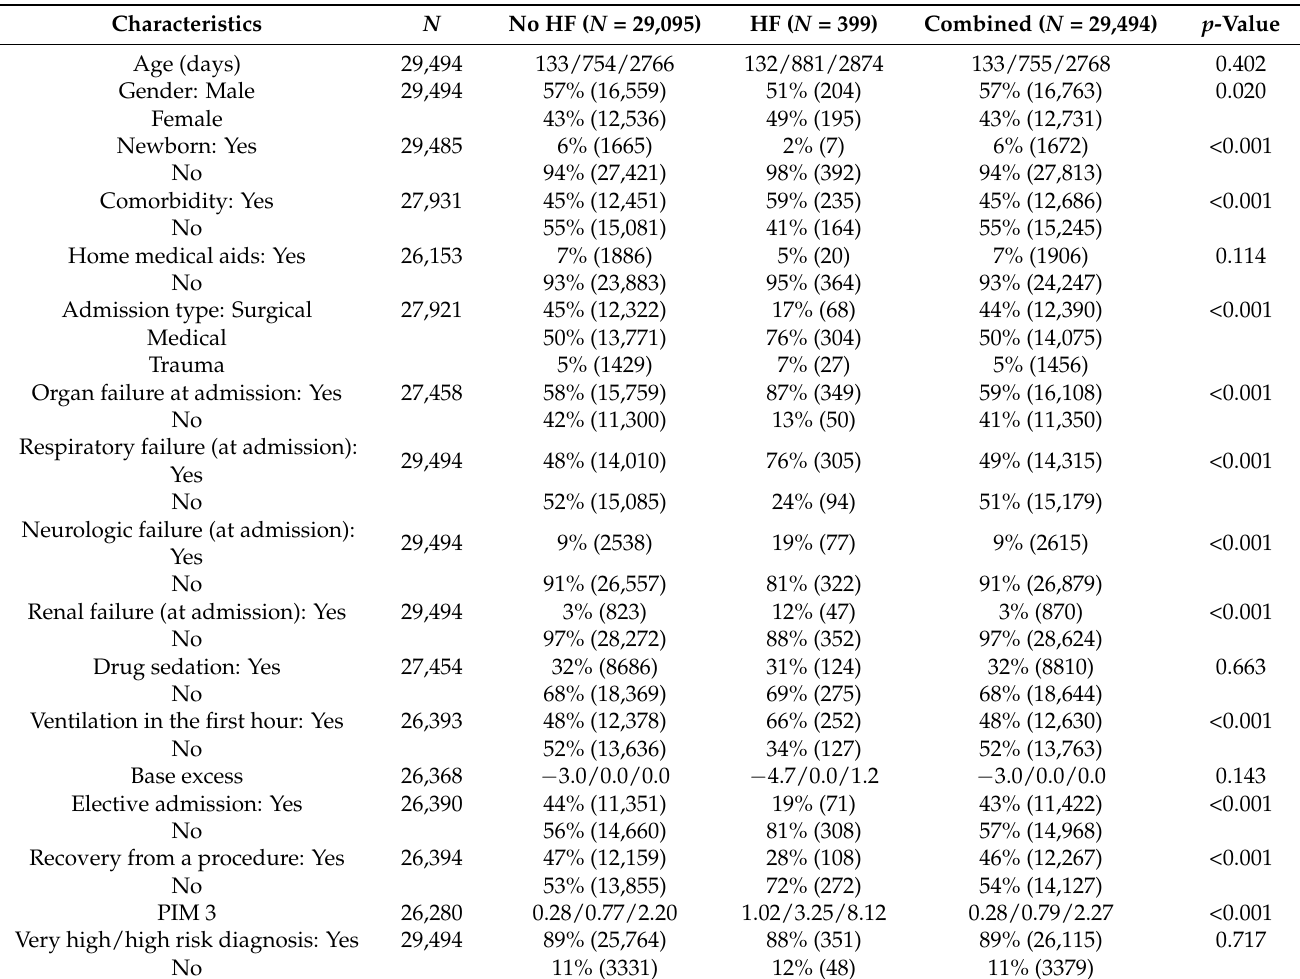
Table 1. Subjects’ baseline characteristics according to outcome development (HF). Data are I quartile/median/III quartile for continuous variables and percentages (absolute numbers) for categorical